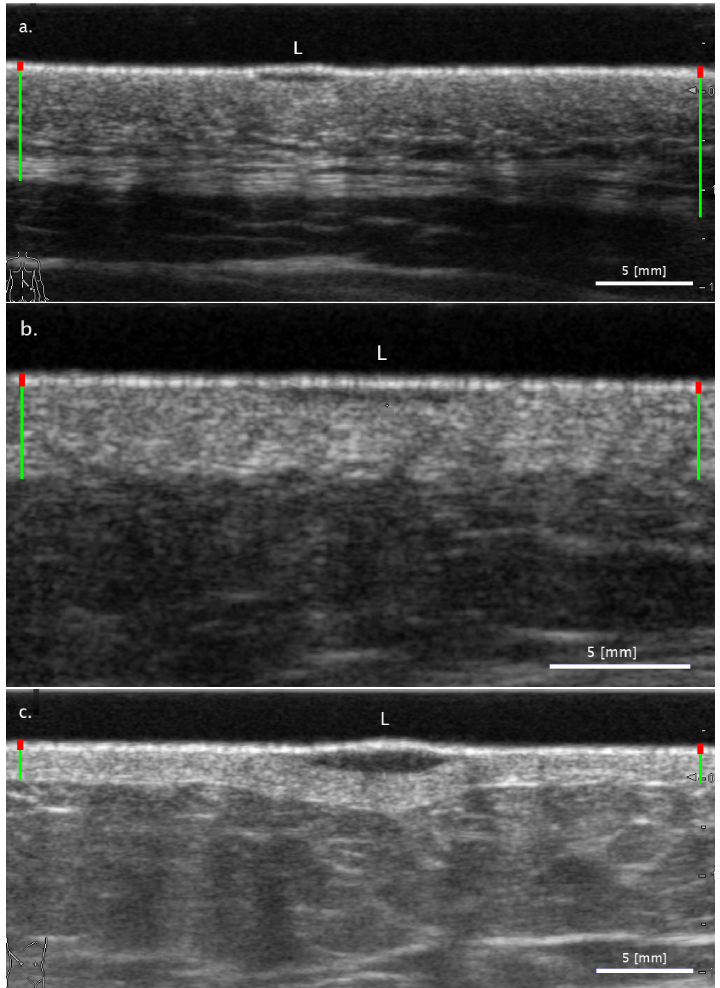
Figure 1. Representative ultrasound images of the three examined lesion types. ( a ) Nevus; ( b ) BCC; ( c ) MM. The primary layers of the skin are marked by the red (epidermis) and green (dermis) marks on the sides of the images. The lesions are marked by a white letter ‘L’ placed above them on the